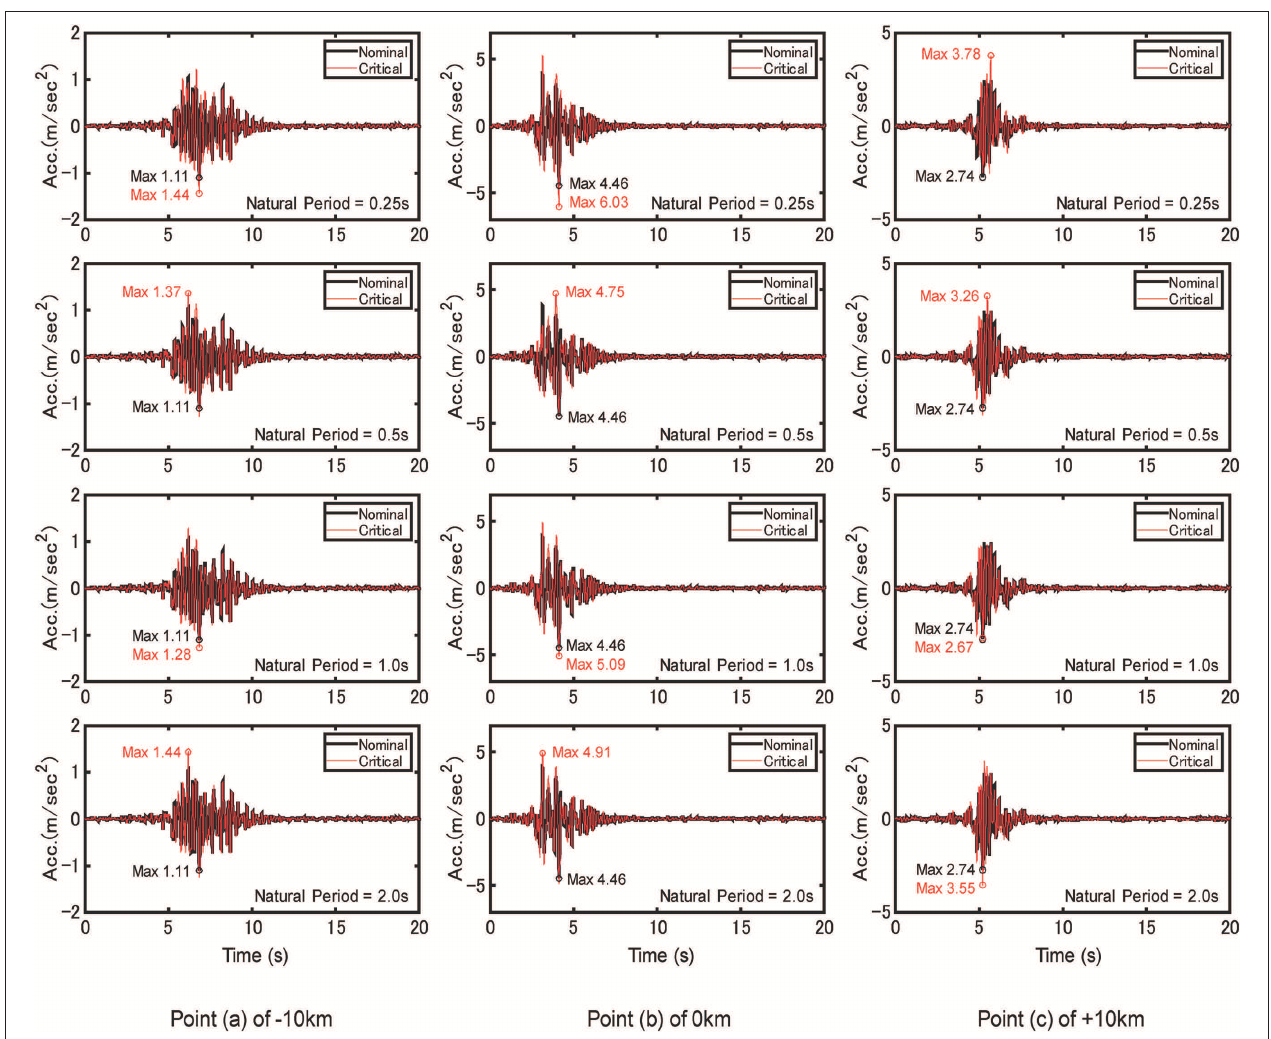
FIGURE 7 | Nominal and critical ground surface accelerations of four MDOF models with different number of stories ( T 1 = 0.25 s , 0.5 s , 1.0 s , 2.0 s ) at three points (Straight lowest natural mode).